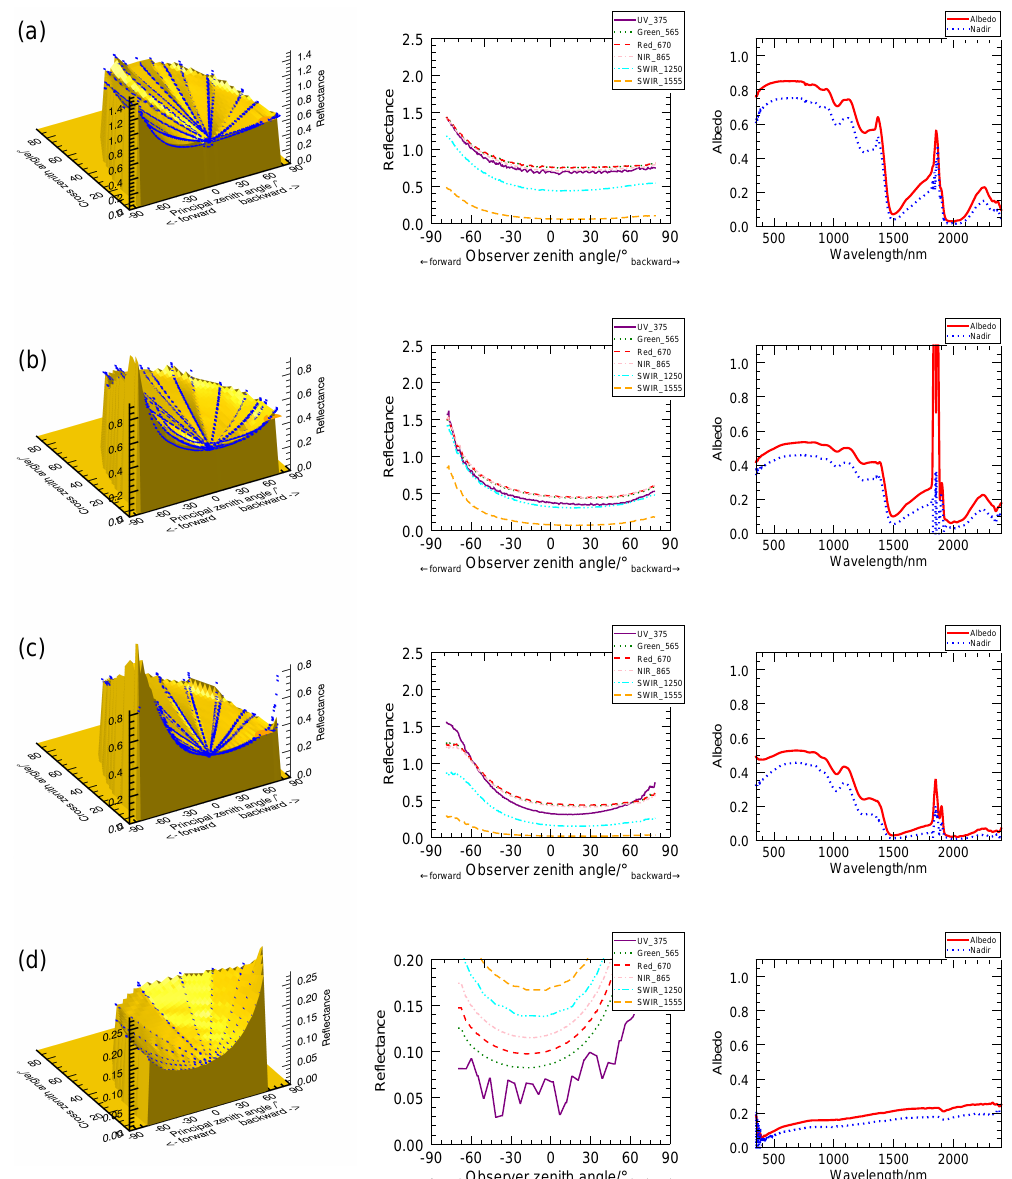
Figure 11. As in Fig. 9. (a) 10g of silt/0.5m 2 on top of snow, on the 4 April 2013 at 15:05, 65 ◦ ; (b) 10g of silt/0.5m 2 , on the 4 April 2013 at 16:29, 72 ◦ ; note large solar zenith angle; (c) same sample on the 5 April 2013 at 11:16, 61 ◦ ; the difference to b is due to a different solar zenith angle; (d) pure silt measured in the laboratory, 65 ◦